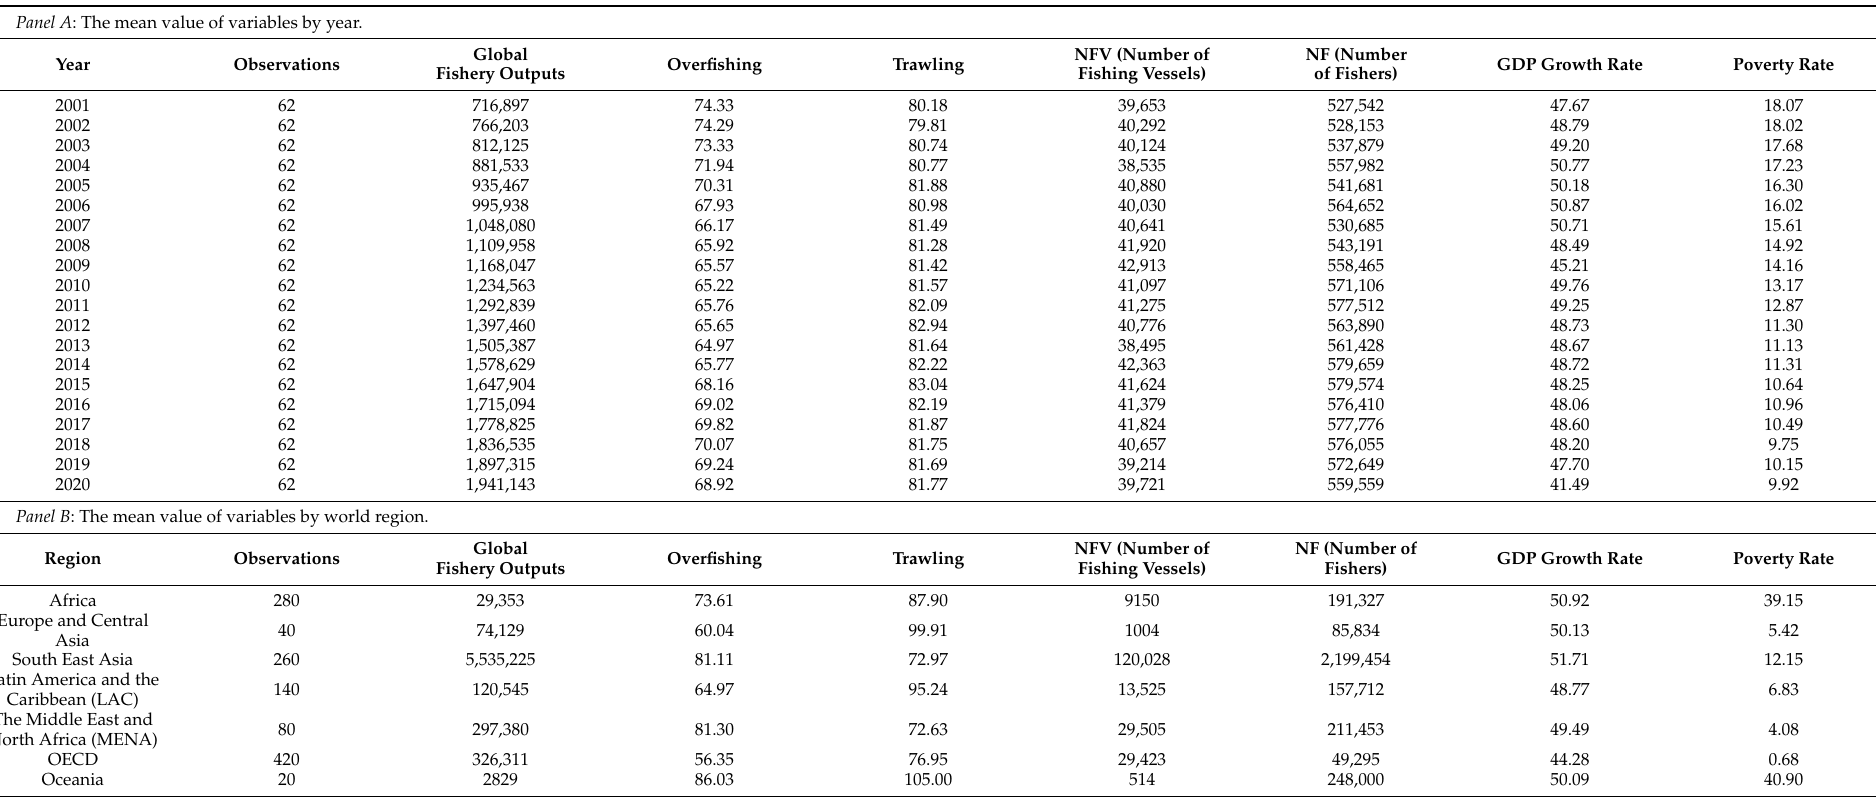
Table 1. The descriptive statistic variables by year, region, and country from 2001 to 2020. Panel A : The mean value of variables by year.